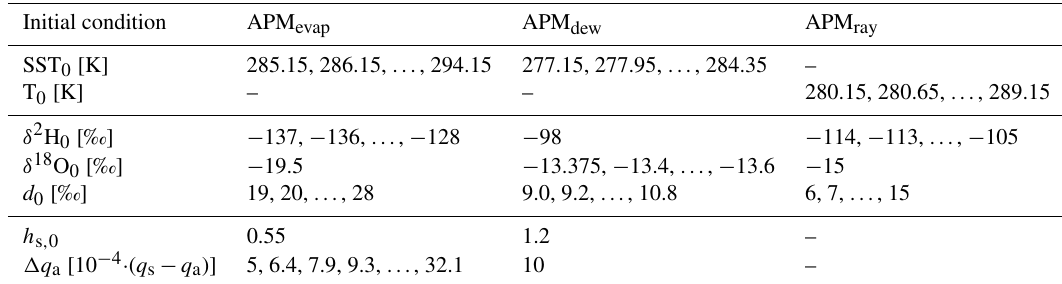
Table B1. Specifications of APM simulations in Fig.